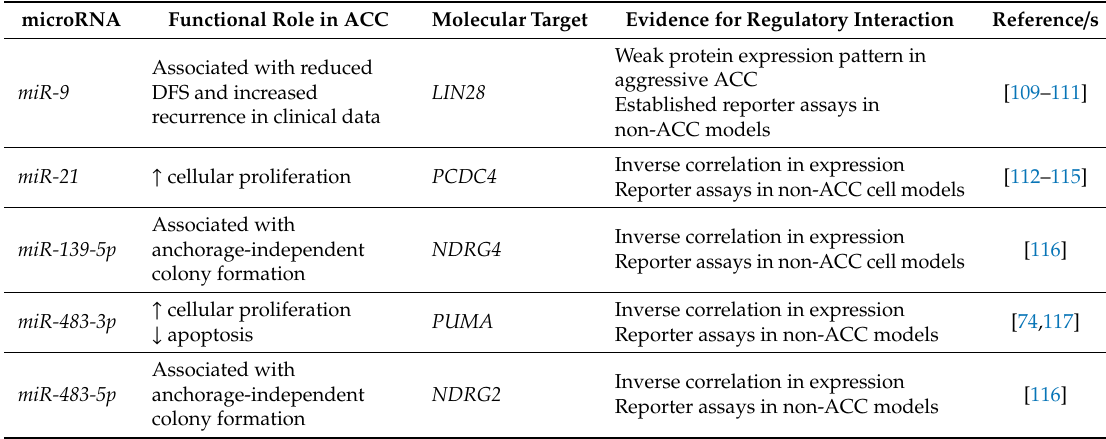
Table 3. Overexpressed microRNAs and their regulated targets in